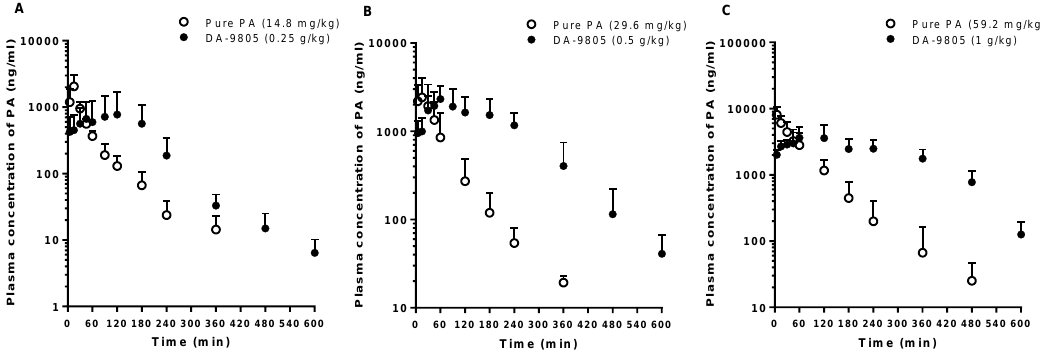
Figure 4. Mean arterial plasma concentration–time profiles of PA following oral administration of DA-9805 (closed circle) at doses of 0.25 g/kg ( A ; 14.8 mg/kg as PA, n = 5), 0.5 g/kg ( B ; 29.6 mg/kg as PA, n = 5), and 1 g/kg ( C ; 59.2 mg/kg as PA, n = 5) mg/kg and equivalent doses of pure PA (open circle; 14.8 mg/kg ( A ; n = 4), 29.6 mg/kg ( B ; n = 5), and 59.2 mg/kg ( C ; n = 4)) to rats. Vertical bars represent SD.